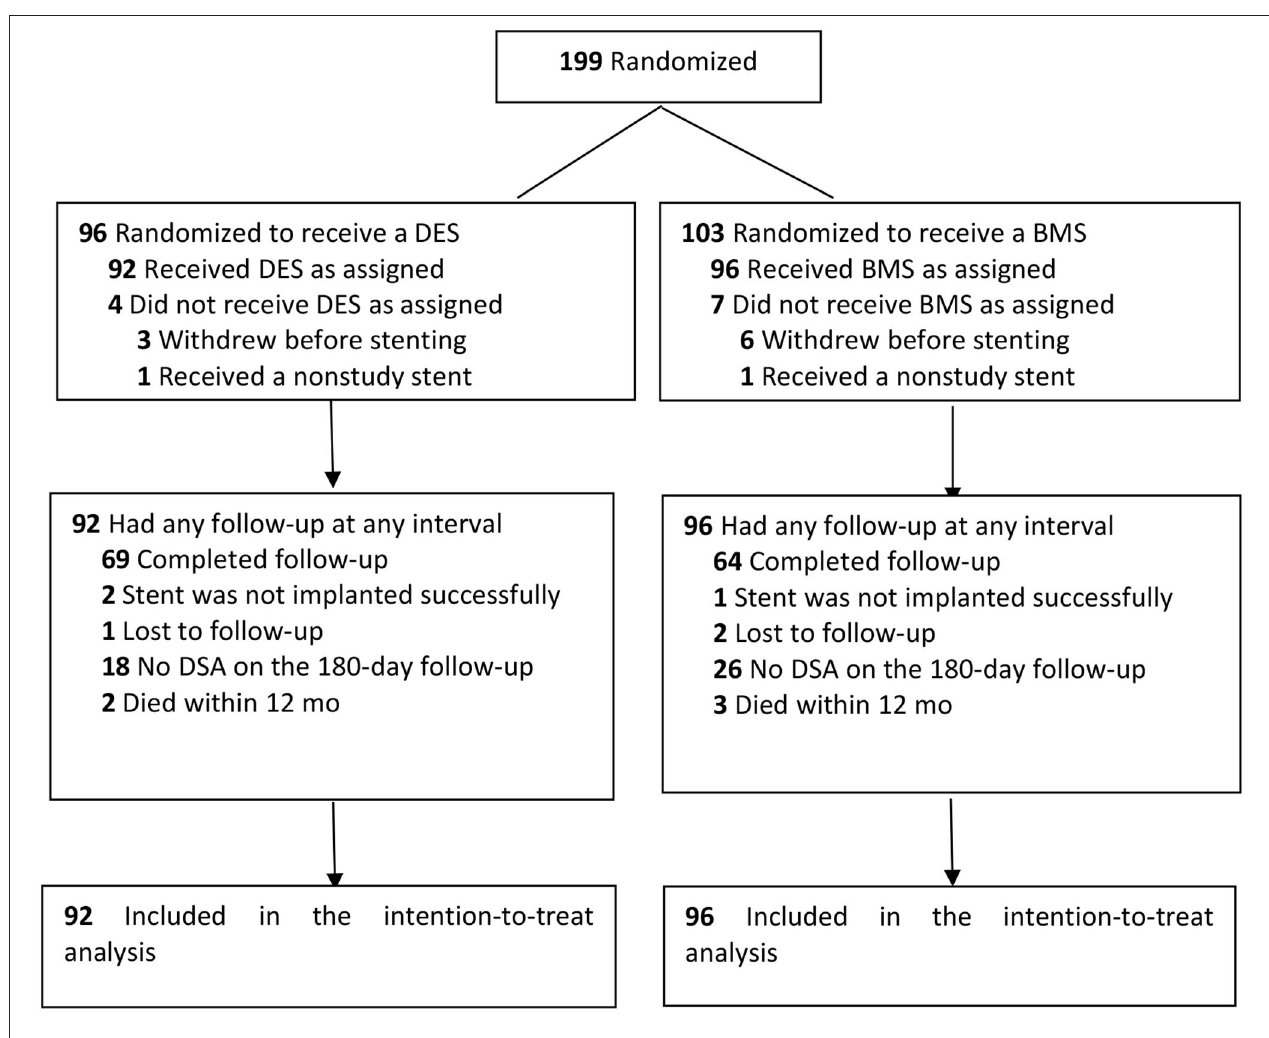
FIGURE 1 | Design of the trial and flow of